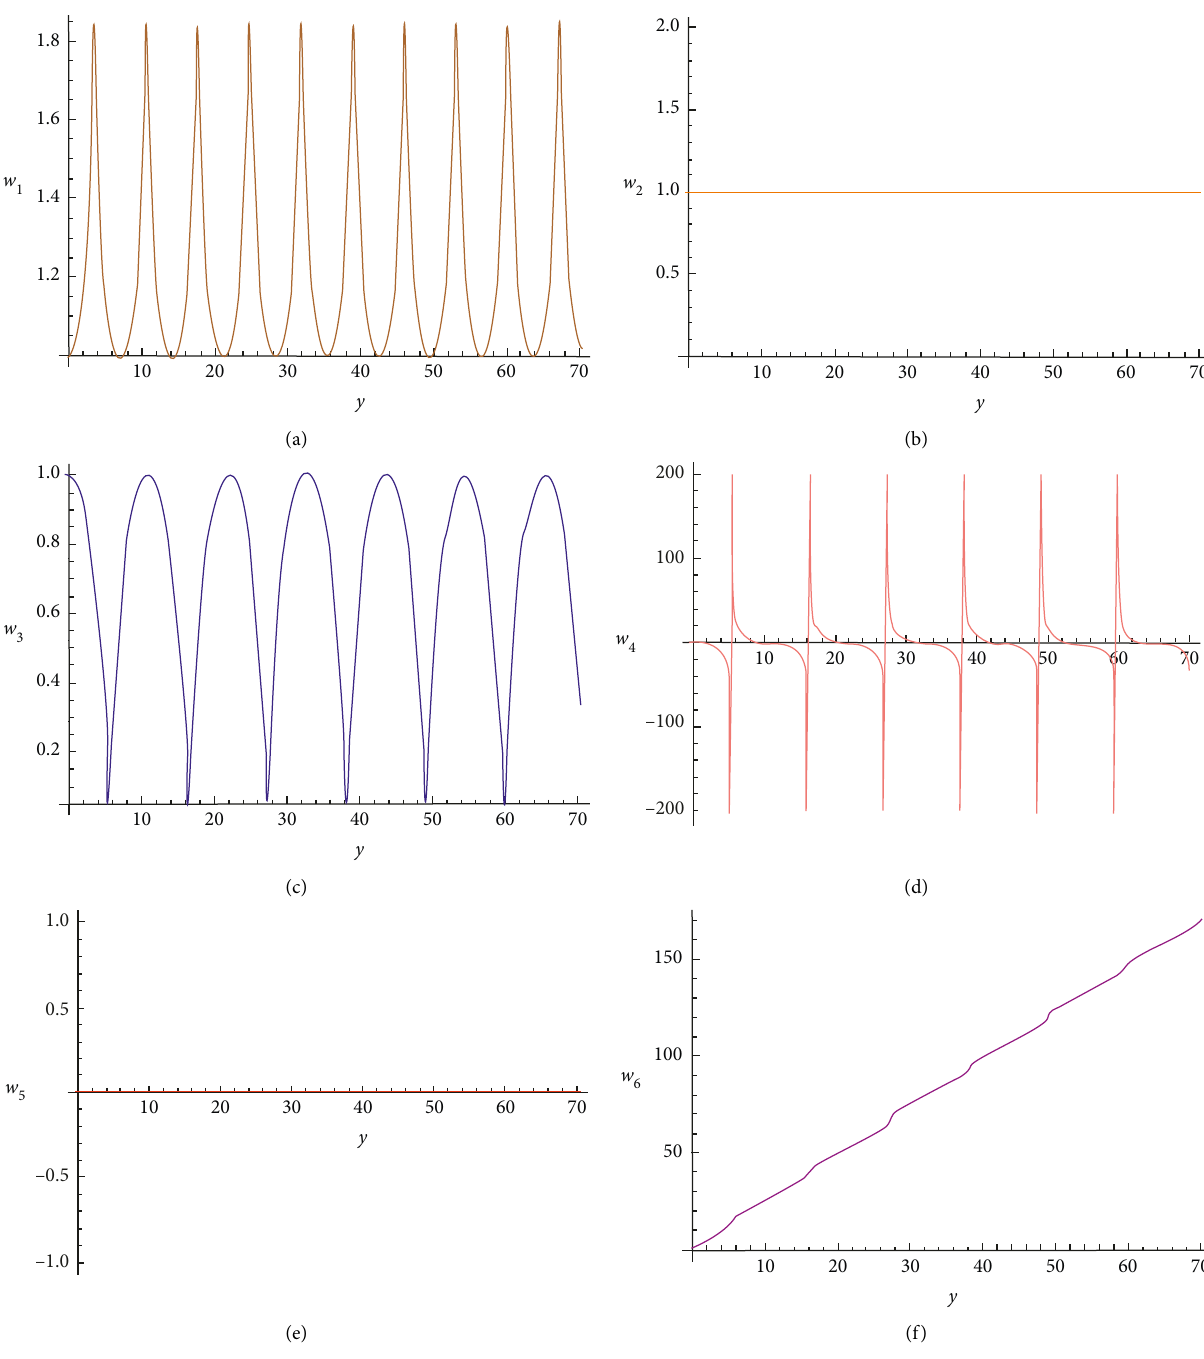
, ( i � 1 , 2 , ... , 6 ) with distance of propagation y taking initial values w i